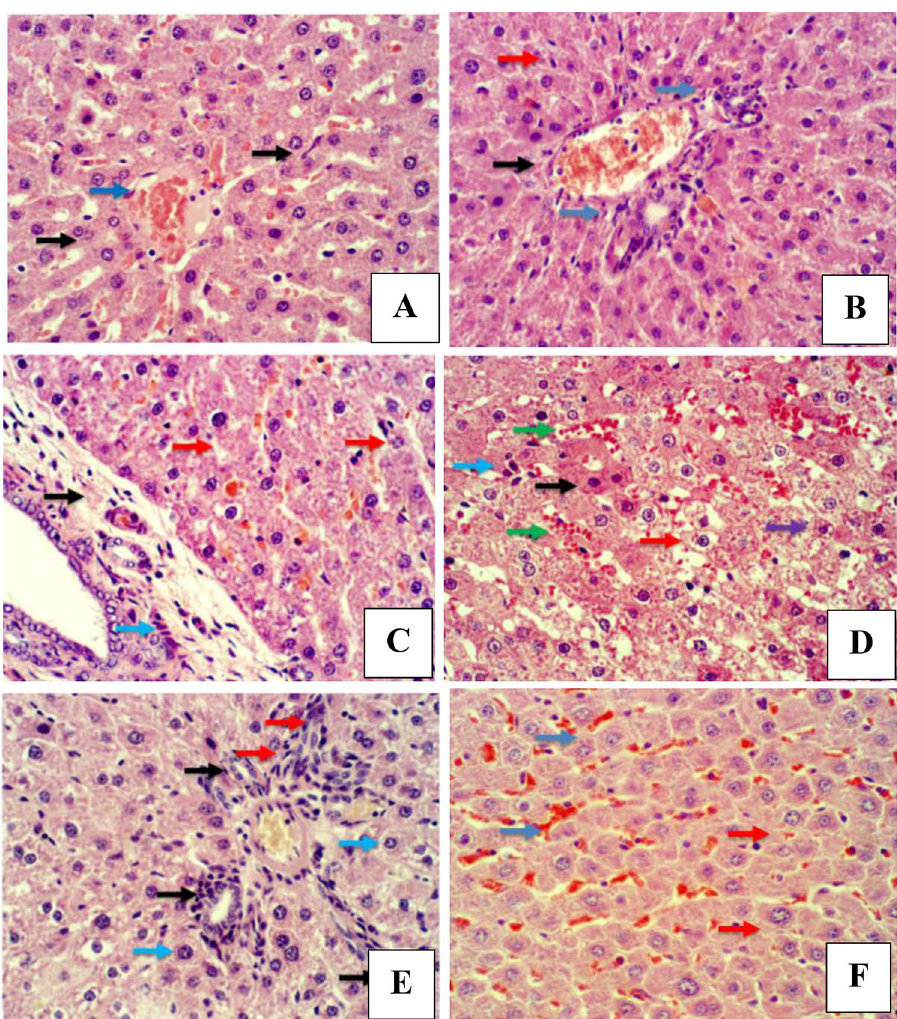
Figure 4. Liver section, H&E. 400×. ( A ) Placebo group/3 weeks, shows normal histological features of hepatic cords (black arrow), and central vein (blue arrow). ( B ) Placebo group/ 6 weeks, shows normal histological features of blood vessels in portal area (black arrow), and bile cuniculi (blue arrow), hepatocytes (red arrow). ( C ) DEN group/3 weeks, shows fibrosis around portal area (black arrow), hyperplasia of Kupffer cells (blue arrow), and dilatation of sinusoids (red arrow). ( D ) DEN group/6 weeks, shows hepatocellular adenoma (black arrow), hyperplasia of Kupffer cells (blue arrow), vacuolar degeneration (red arrow), coagulative necrosis (purple arrow), with dilatation of sinusoids (green arrow). ( E ) 5B2T group/3 weeks, shows hyperplasia of bile cuniculi (black arrow), necrotic hepatocytes (blue arrow), and infiltration of inflammatory cells (red arrow). ( F ) 5B2T group/6 weeks, ShowS mild peliosis (blue arrow), and few hepatocytes showed cellular degeneration (red